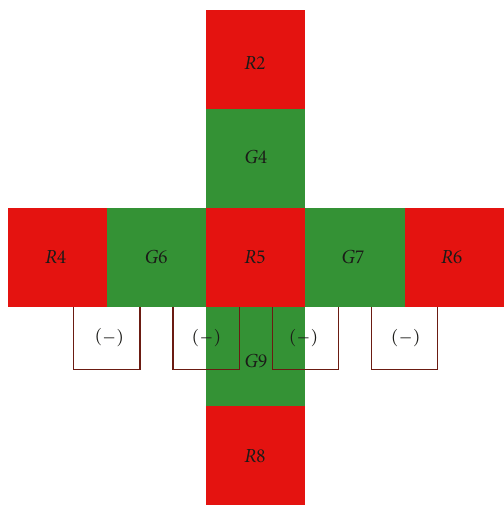
Figure 4: Spectral and spatial